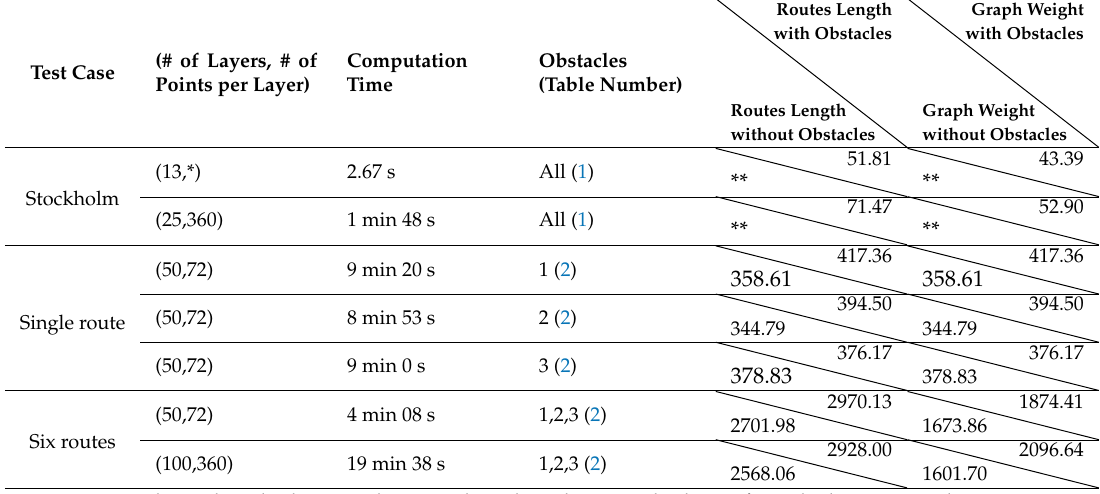
Table 3. The numerical results of the